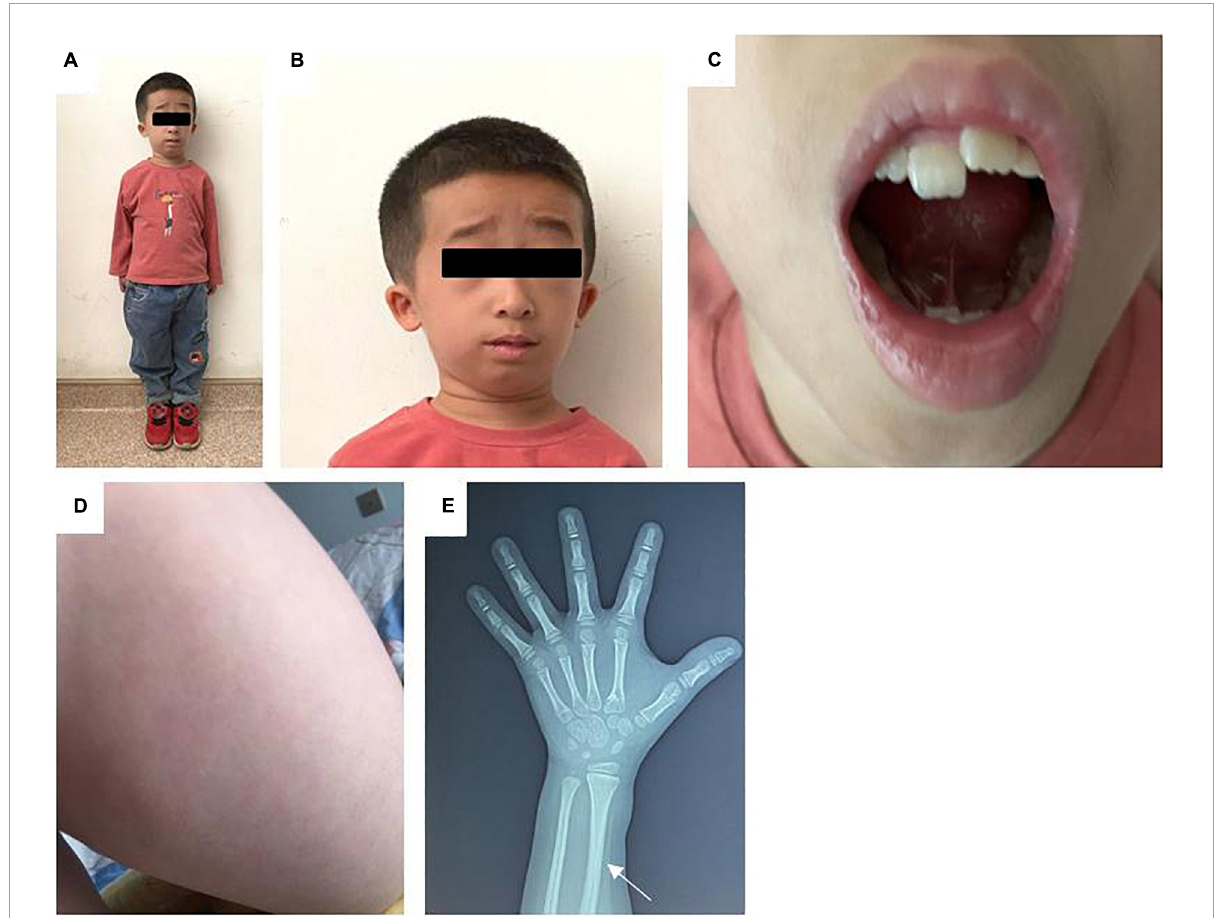
FIGURE2 (A) Full body photograph of the patient. (B) Photograph of the child’s face: zygomatic arch dysplasia, a high forehead, low anterior hairline, low-set ears, a long nasal tip and columella, and a small mouth. (C) Photograph of the child’s irregular teeth. (D) Photograph illustrating the livedo on the skin of the patient’s thigh. (E) X-ray of the left hand. The white arrow indicate a thickened radial cortex, a narrow medullary cavity, and a bent radial